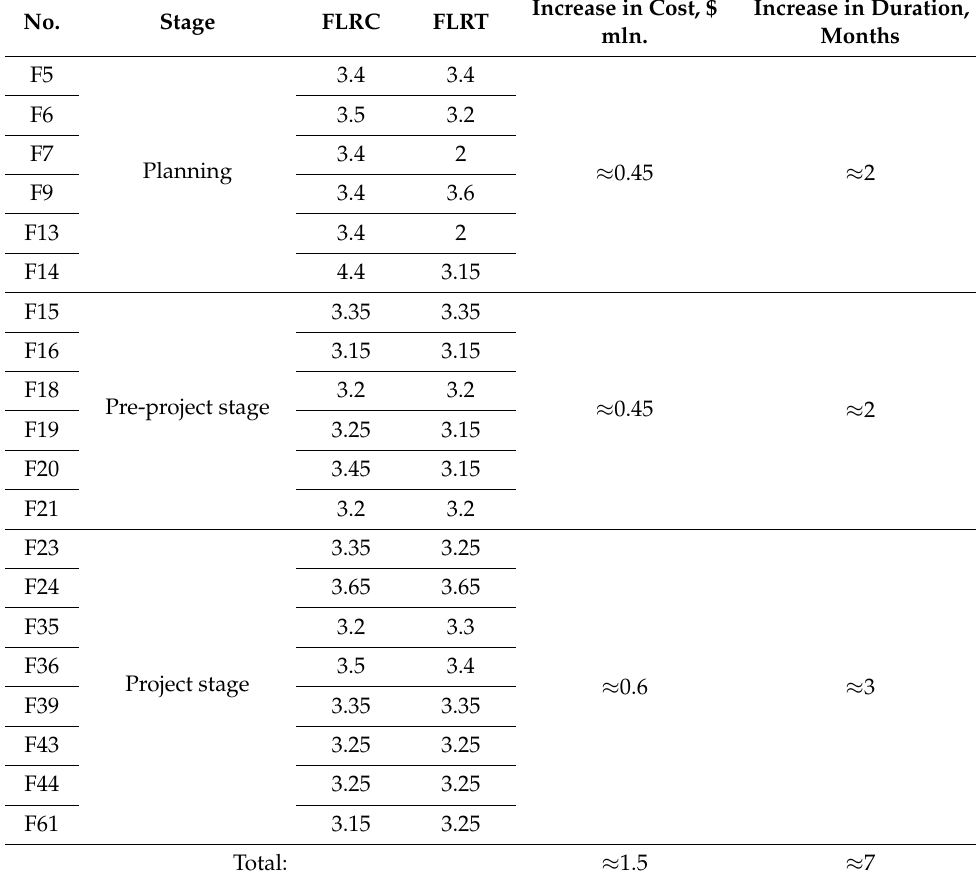
Table 7. Critical risk factor